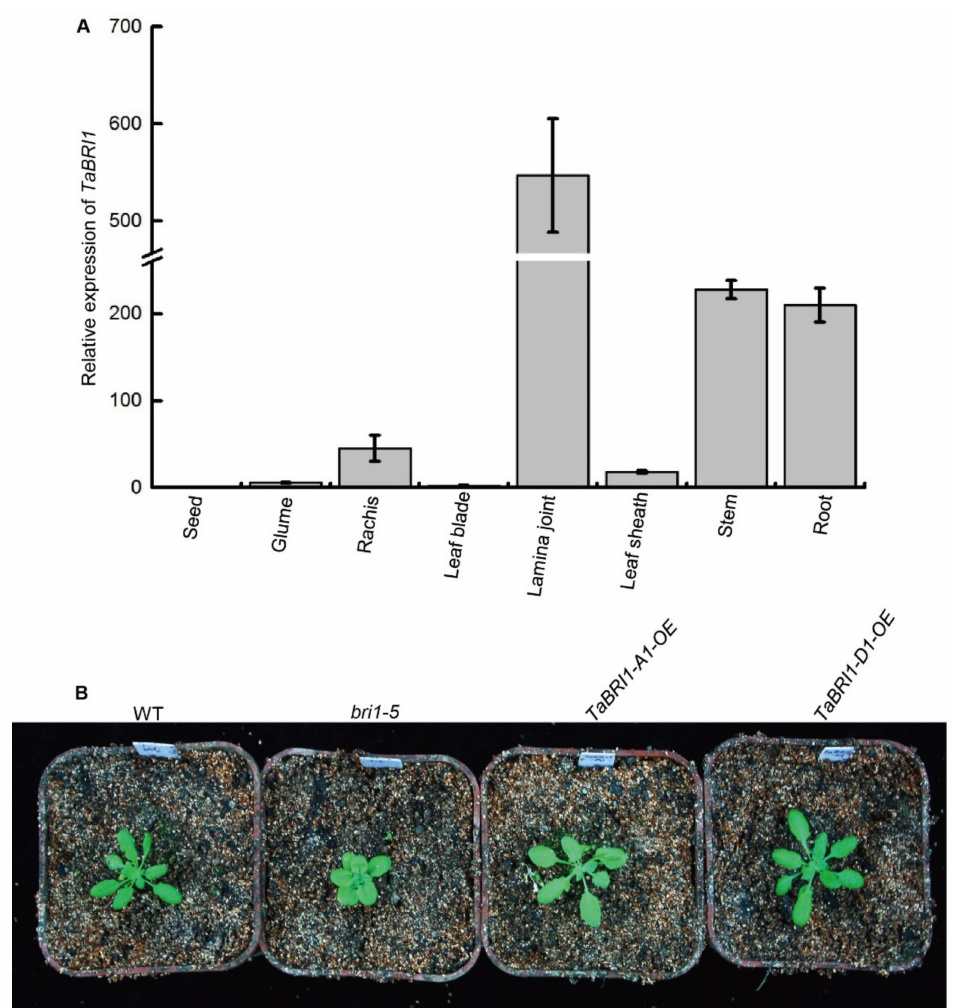
Figure 2. Expression pattern of TaBRI1 gene and complementation analysis in the Arabidopsis bri1-5 mutant by expressing TaBRI1 . ( A ) Expression of TaBRI1 in various tissues analyzed by real-time PCR. Various tissues were collected from plants at the reproductive stage. Each tissue had three biologic replicates and each biologic replicate comprised a pool of five plants; ( B ) complementation analysis in the Arabidopsis bri1-5 mutant by expressing TaBRI1-A1 and -D1 ,